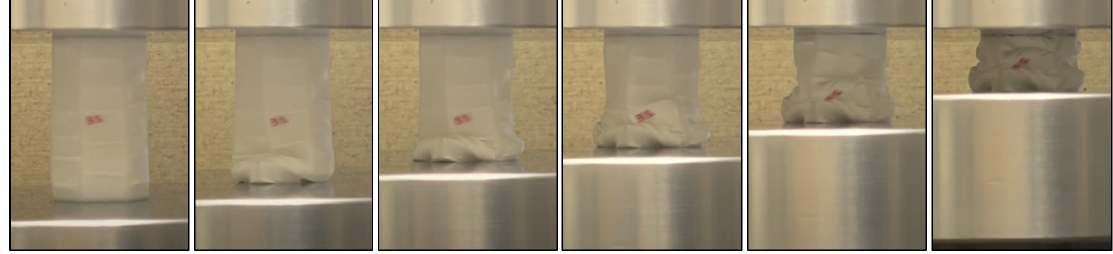
Figure 16. Experimental load vs. displacement curves for hexagonal cell under axial load.